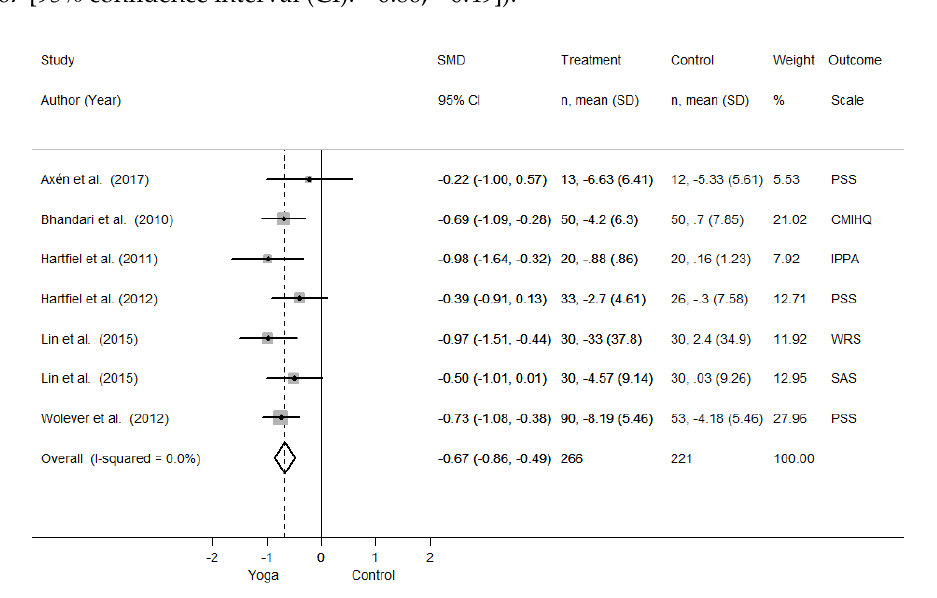
Figure 4. Forest plot reporting quantitative analysis. SMD = Standardized Mean Difference. CI = Confidence Interval. SD = Standard Deviation. PSS = Perceives Stress Scale. CMIHQ = Cornel Medical Index Health Questionnaire, IPPA = Inventory of Positive Psychological Attitudes, WRS = Work-Related Stress Scale, SAS = Stress Adaption